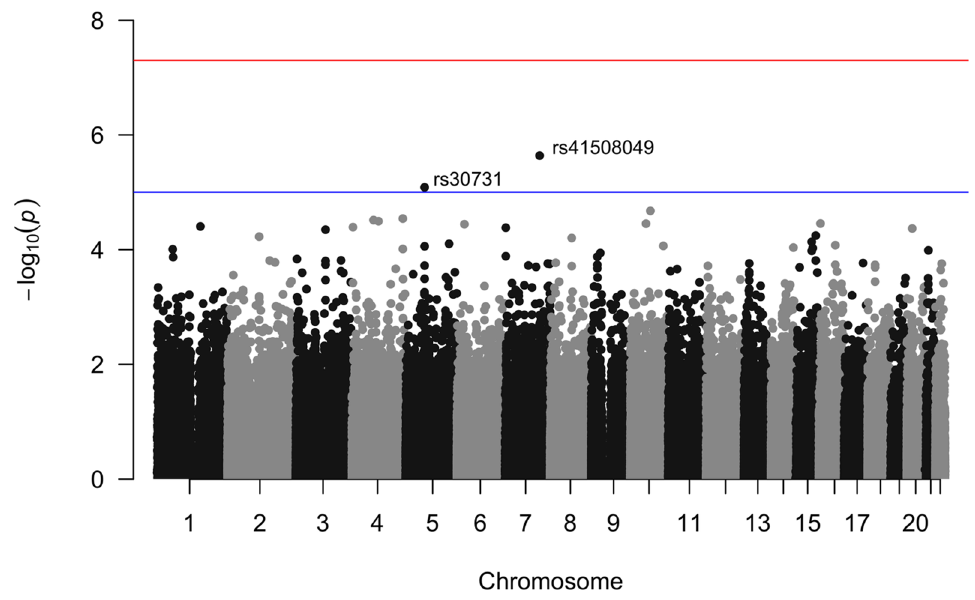
Fig 4. Manhattan plot of sibling variation in BMI among FHS 3rd generation sibling pairs. Results for the pairwise sibling standard deviation in BMI regressed against the sibling minor allele count with controls for sex of sibship, mean age of siblings, age difference of siblings, sibling mean BMI, and parental